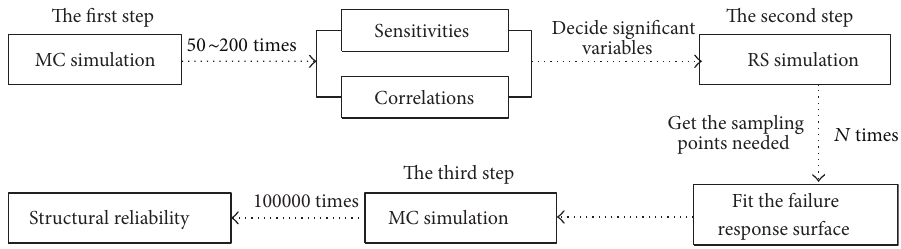
Figure 17: The flow chart of the combined simulation